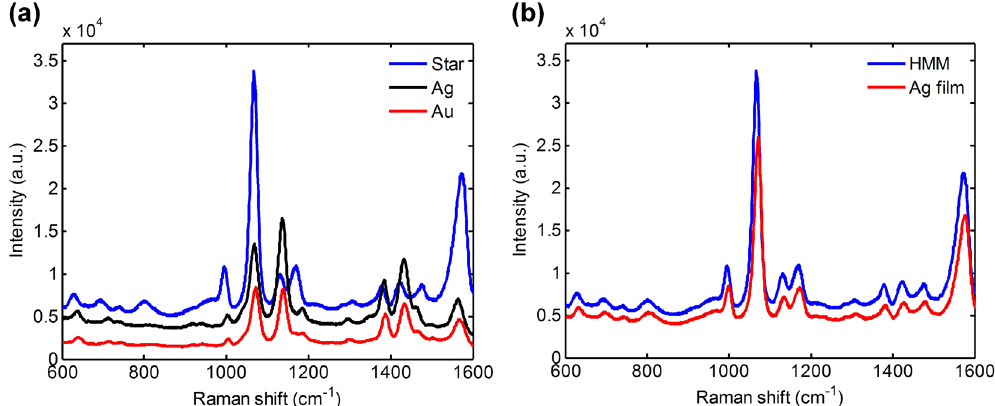
Figure 5. Raman spectra of 4-ATP molecule with the HMM-based substrates. ( a ) Raman spectra of 4-ATP molecule with the HMM-based substrates employing gold, silver, and star-shaped gold/silver nanoparticles. ( b ) Comparison between the HMM-based and the silver film-based substrates, both employing star-shaped